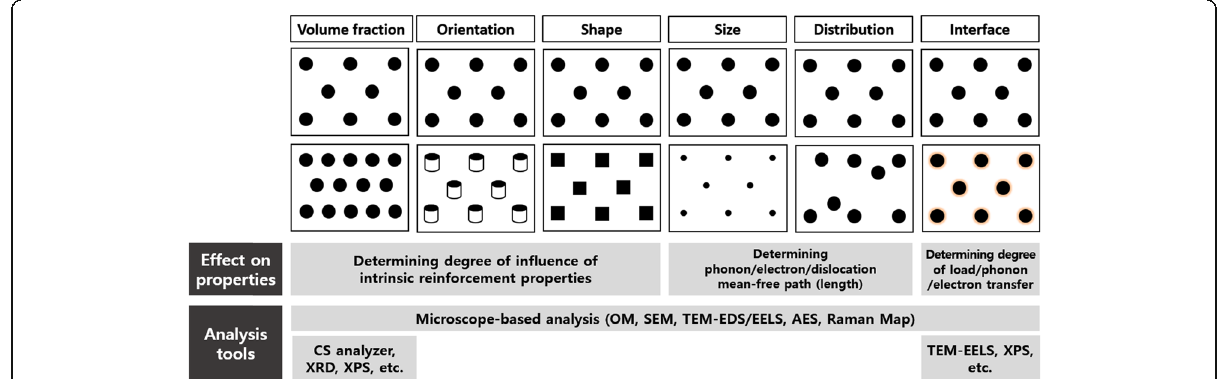
Fig. 1 Overview of characterization tools to examine microstructural valuables and their roles on the properties of composites containing carbon